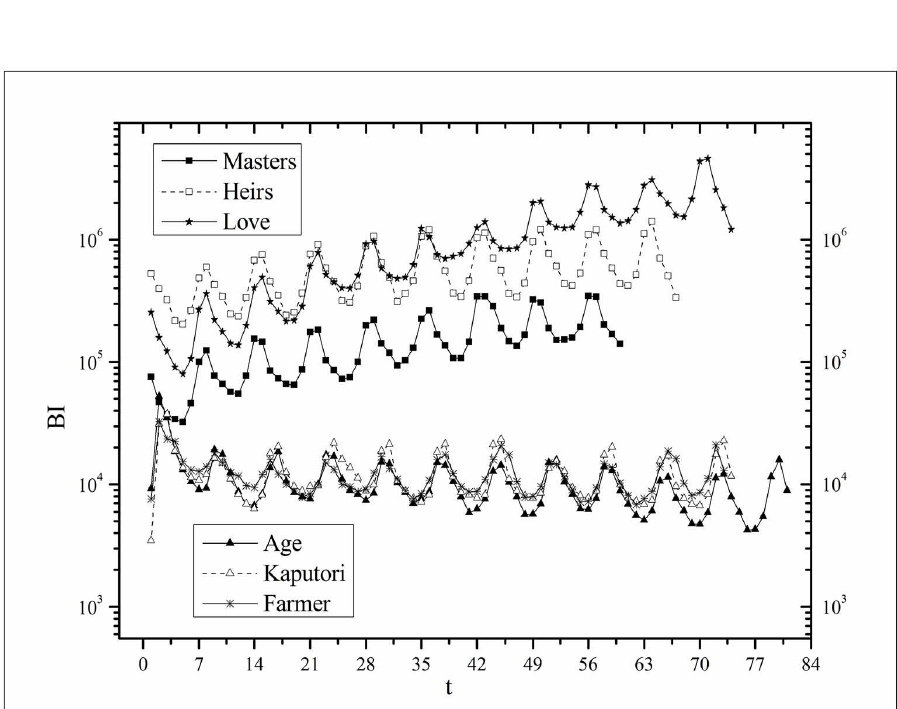
Fig 18. Comparison of BI of the six datasets.